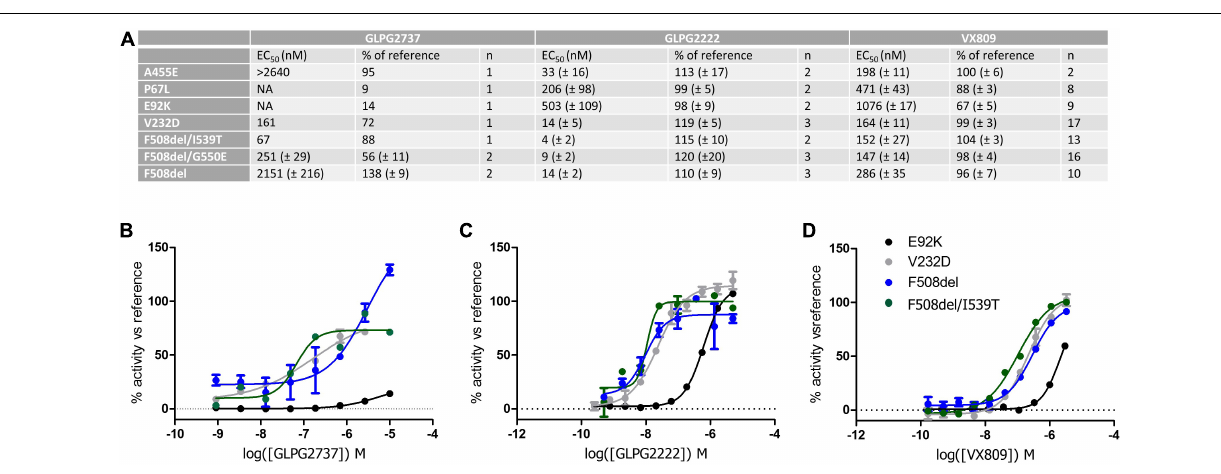
FIGURE 7 | YHA assay using CFTR mutant overexpression in HEK293 cells. Cells were incubated for 24 h with either a dose range of GLPG2737, GLPG2222 or VX809. After washing, cells were triggered with forskolin (50 µ M for F508del, E92K, V232D and F508del/I539T, 10 µ M for P67L or 1 µ M for F508del/G550E) and 0.5 µ M potentiator and YFP fluorescence was measured. Efficacy was determined using 10 µ M GLPG2222 as positive control and DMSO as negative control in the assay. (A) Table with potency and efficacy obtained for the mutants and compounds tested. (B) Dose–response curves of GLPG2737. (C) Dose–response curves of GLPG2222. (D) Dose–response curves of VX-809. For panels (B–D) , E92K mutant is represented in black, F508del mutant in blue, F508del/I539T mutant in green and V232D mutant in gray, all concentrations are tested in